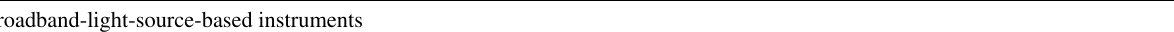
Table 2. Examples for different optical instruments that measure the isotopic composition of CO 2 and reported values for minimal Allan deviations σ A and the corresponding averaging times τ min (if available), see also Table 2 of the review of Griffis